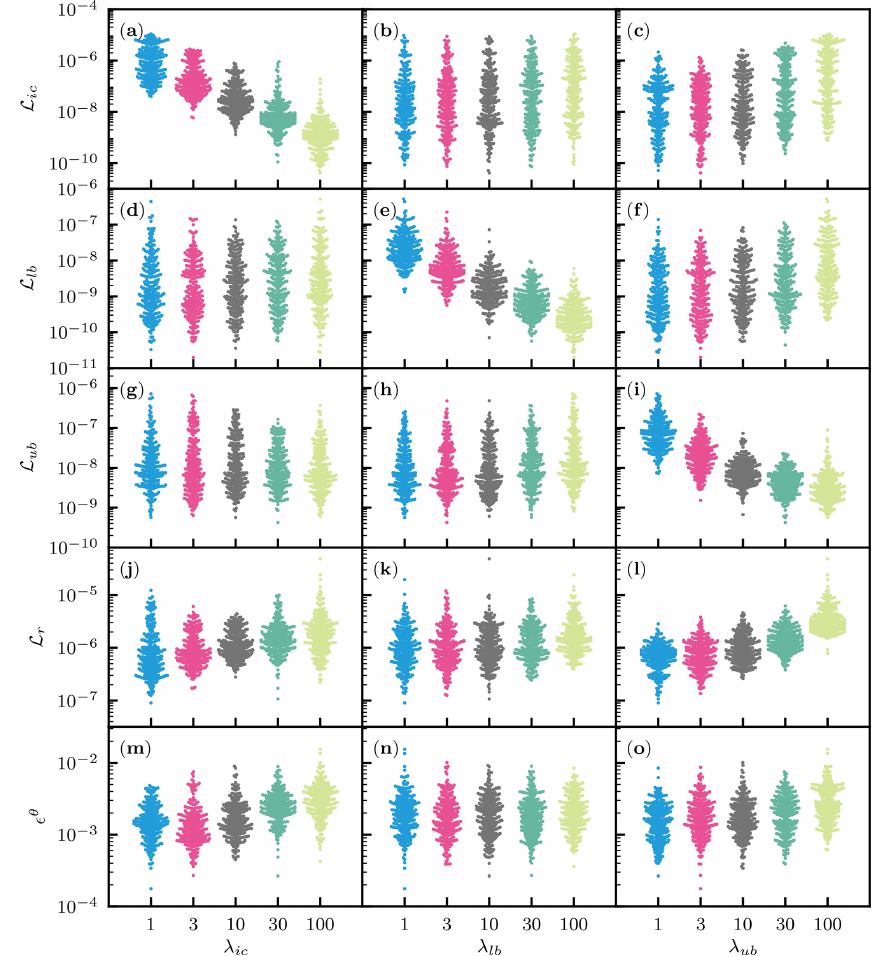
Figure 7. Homogeneous soil. The effects of the weight parameters in the loss function (Eq. 17) for the initial condition λ ic , the lower- boundary condition λ lb , and the upper-boundary condition λ ub on the loss terms L ic , L lb , L ub , and L r for the initial and boundary conditions and the residual of the PDE, respectively, and the relative squared error in terms of volumetric water content (cid:15) θ . λ r was fixed to 1.